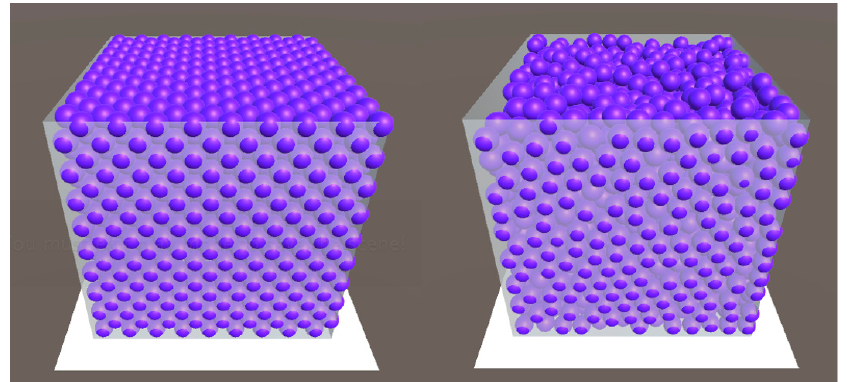
Figure 8. The spatial distribution of theoretical and actual filling of VWMs. The vessel is a cube with a side length of 400 cm; VWM diameter is 30.72 cm; ( Left ): the theoretical maximal filling (2916); ( Right ): the actual filling driven by PhysX (2431).